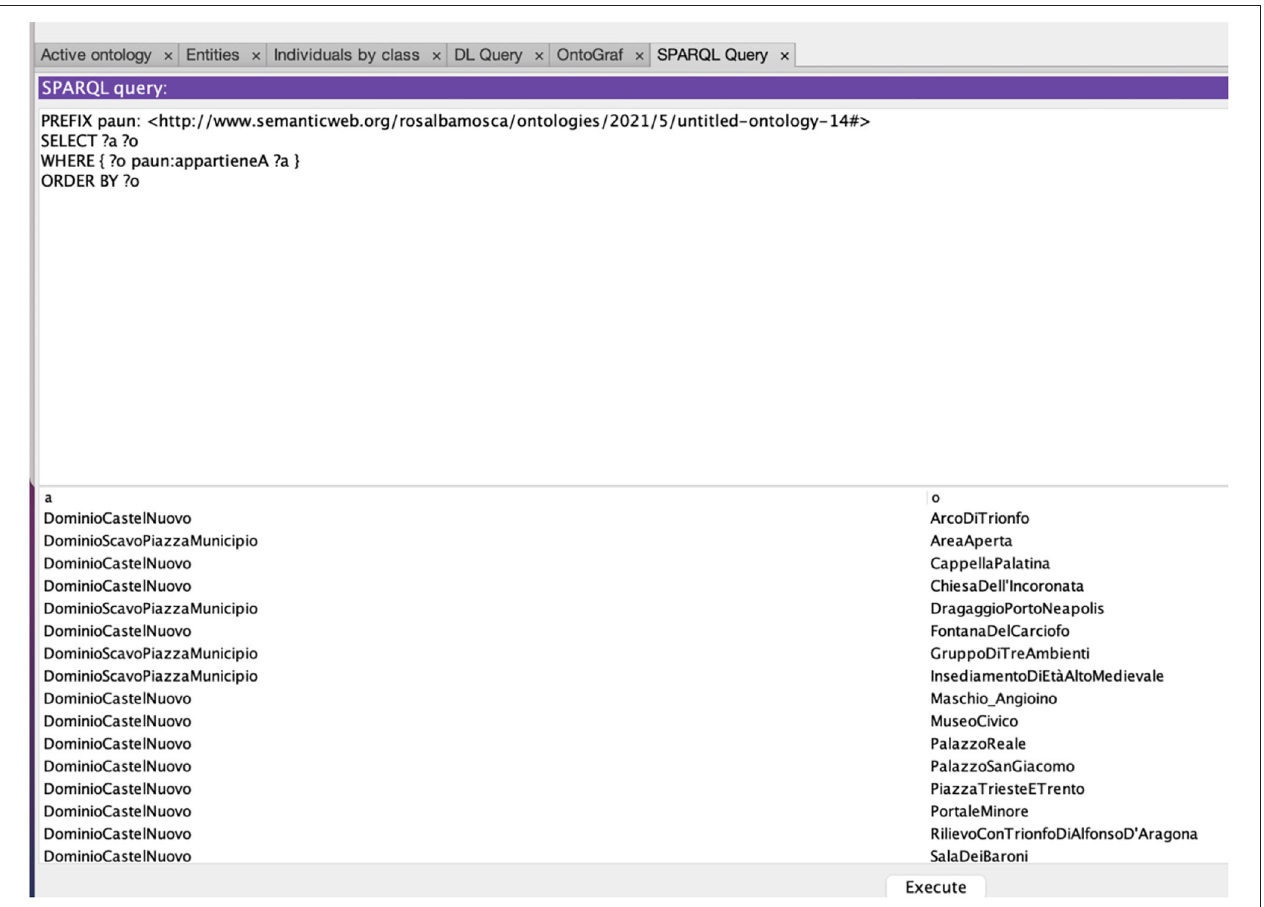
FIGURE 5 | Query on PAUN Ontology showing each asset in the domain it is placed